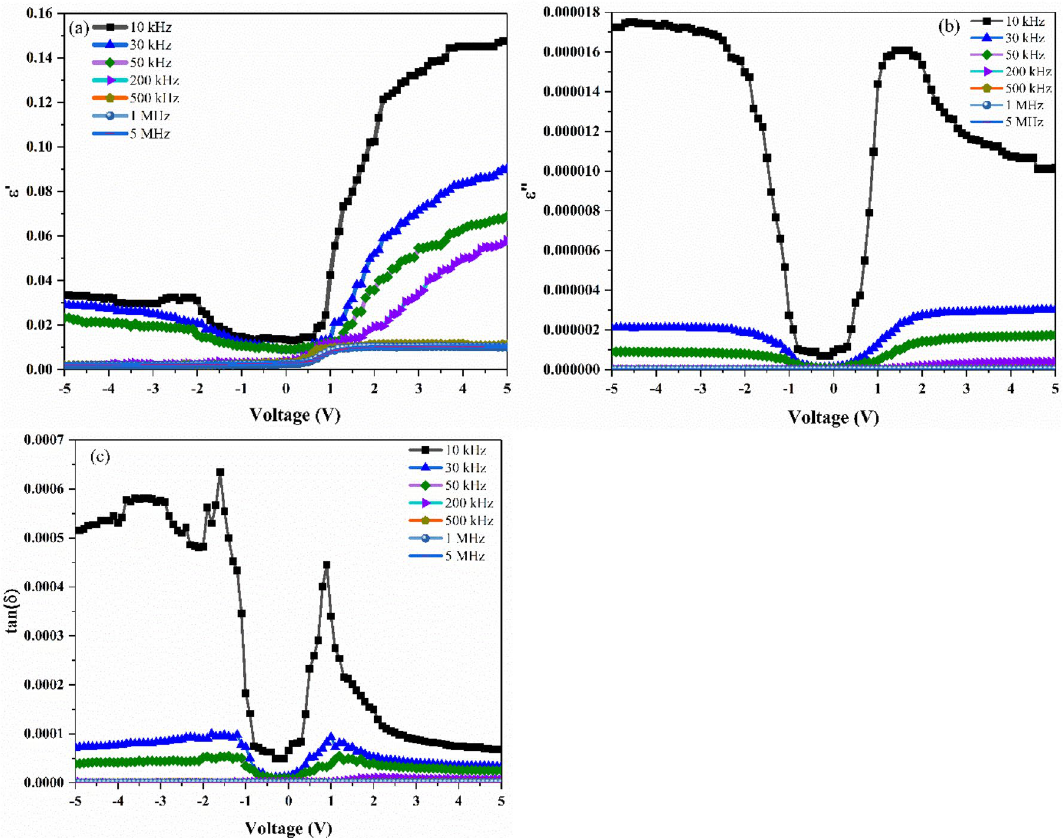
Figure 6. Plot of ( a ) ǫ ′ –V, ( b ) ǫ ″ –V, ( c ) tan(δ)–V for the Ag/TiO 2 -NW/Ge-NW/Si (MOS)